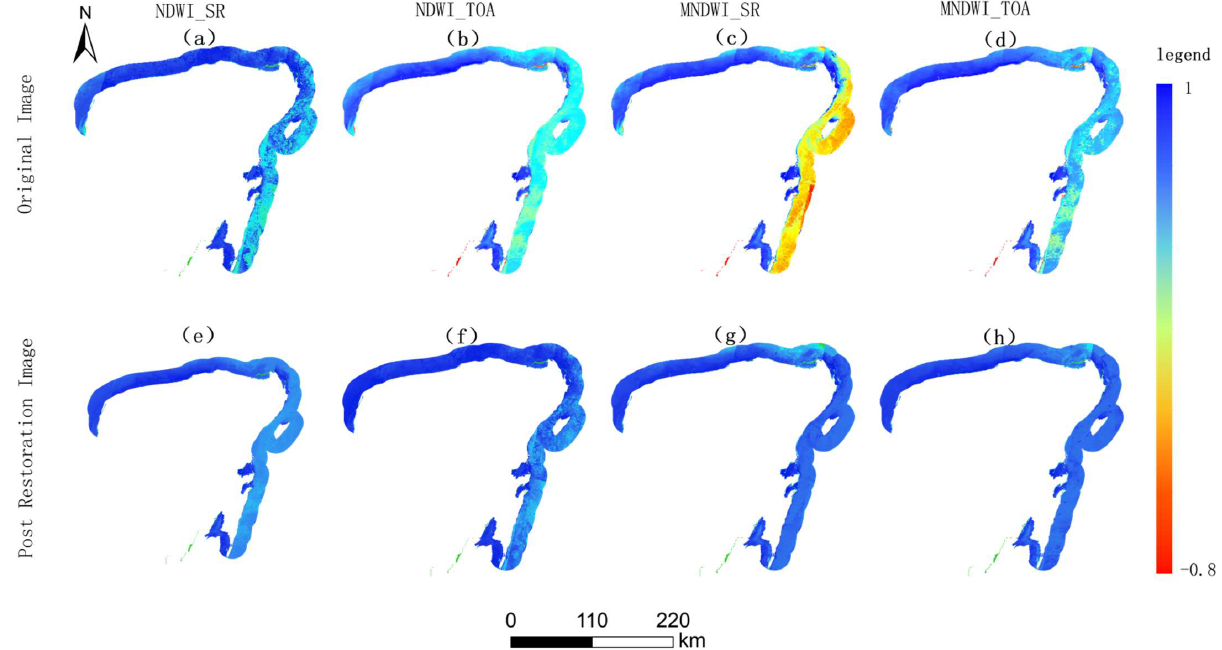
Figure 5. Before and after image restoration in 2016. ( a – d ) Original image; ( e – h ) post-restoration image; ( a , e ) Landsat SR NDWI image; ( b , f ) Landsat TOA NDWI image; ( c , g ) Landsat SR MNDWI image; ( d , h ) Landsat TOA MNDWI image.